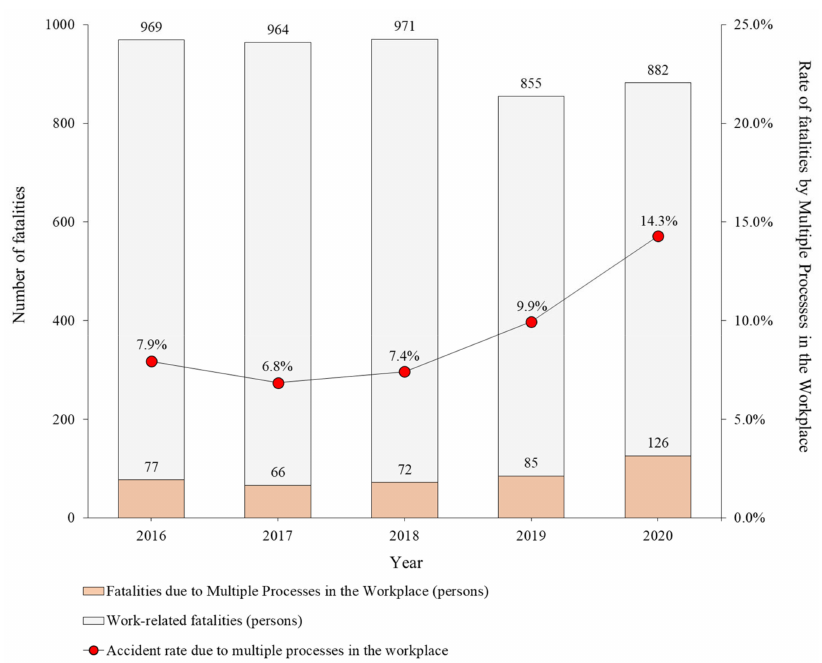
Figure 4. Percentage of fatalities caused by multiple processes in the workplace among work-related fatalities (2016–2020).